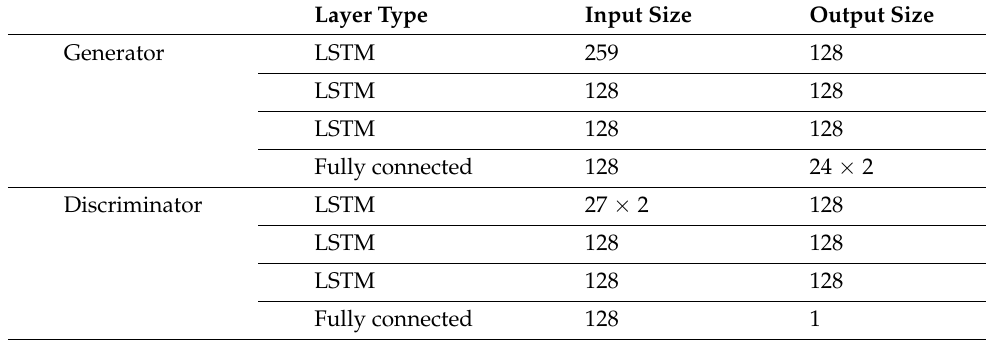
Table 2. Design details of cross-correlated conditional recurrent GAN (C 2 RGAN) model.